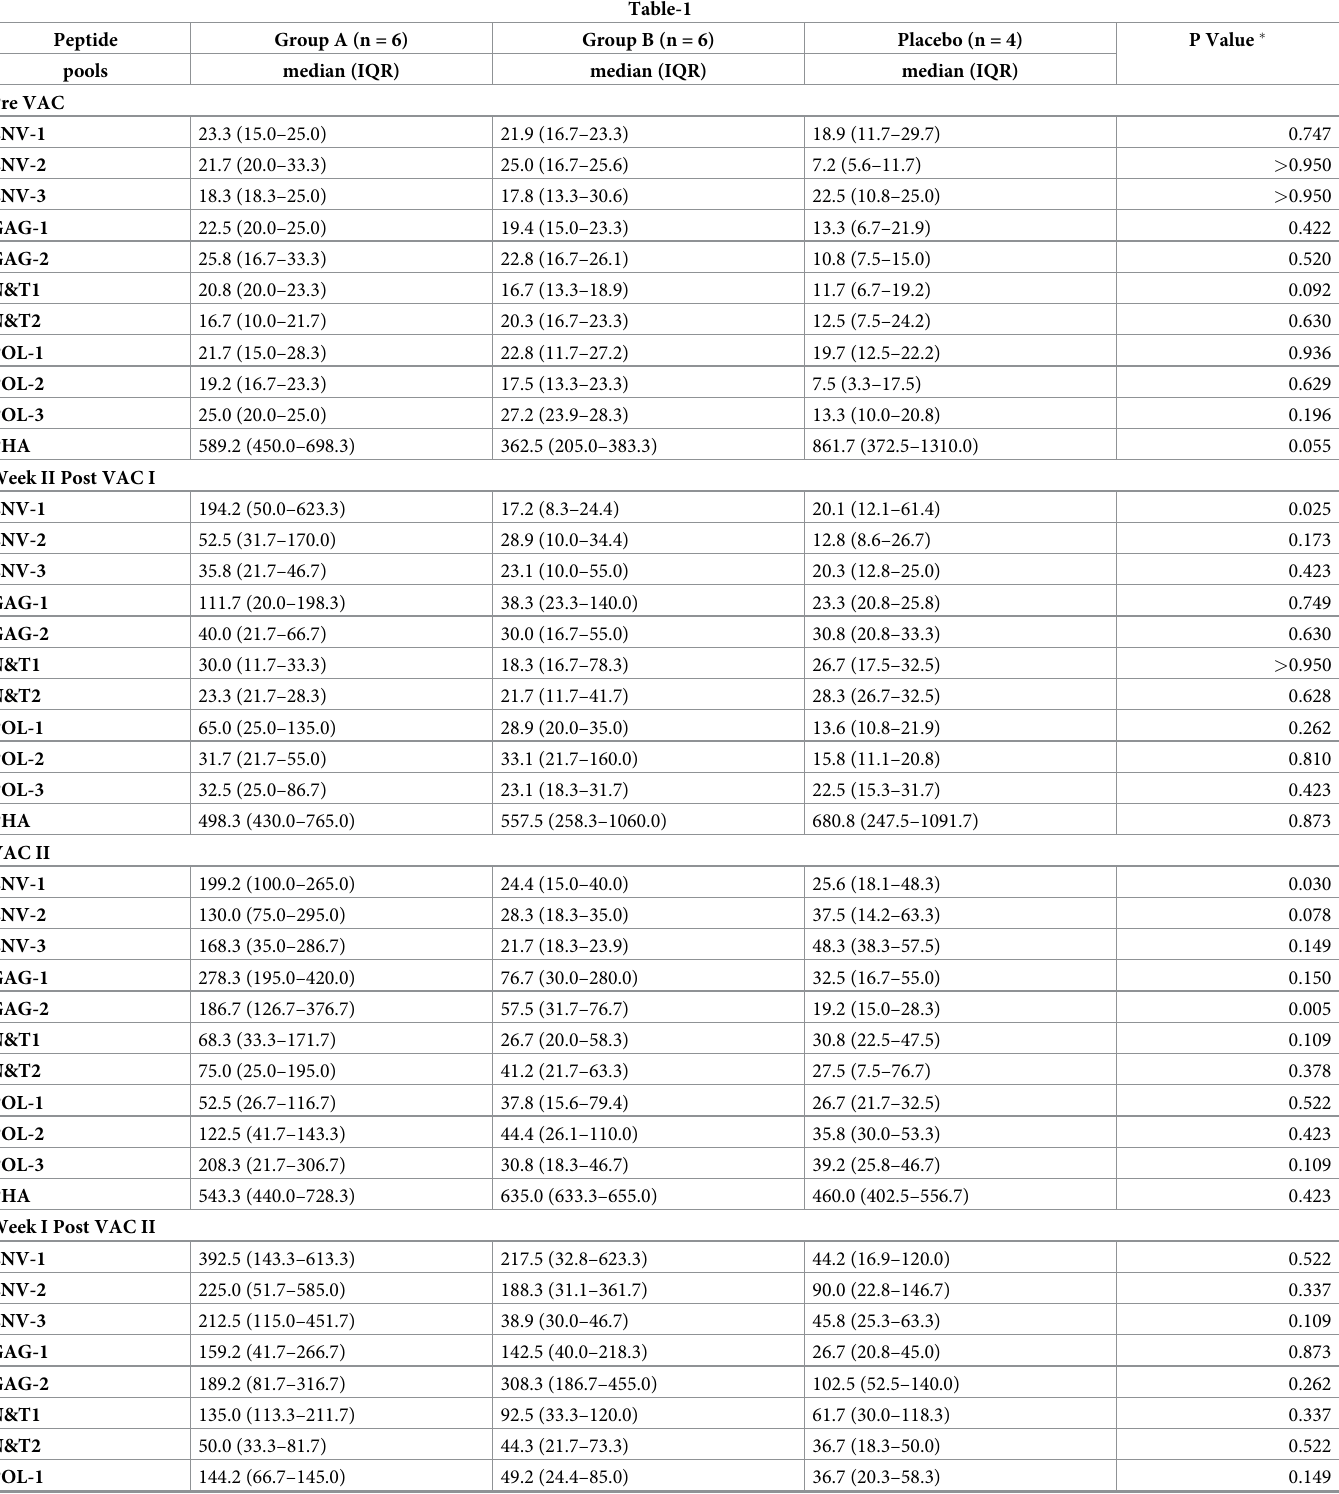
Table 1. Median and range of positive IFN- γ ELISPOT responses (SFC/10 6 PBMC) across different time